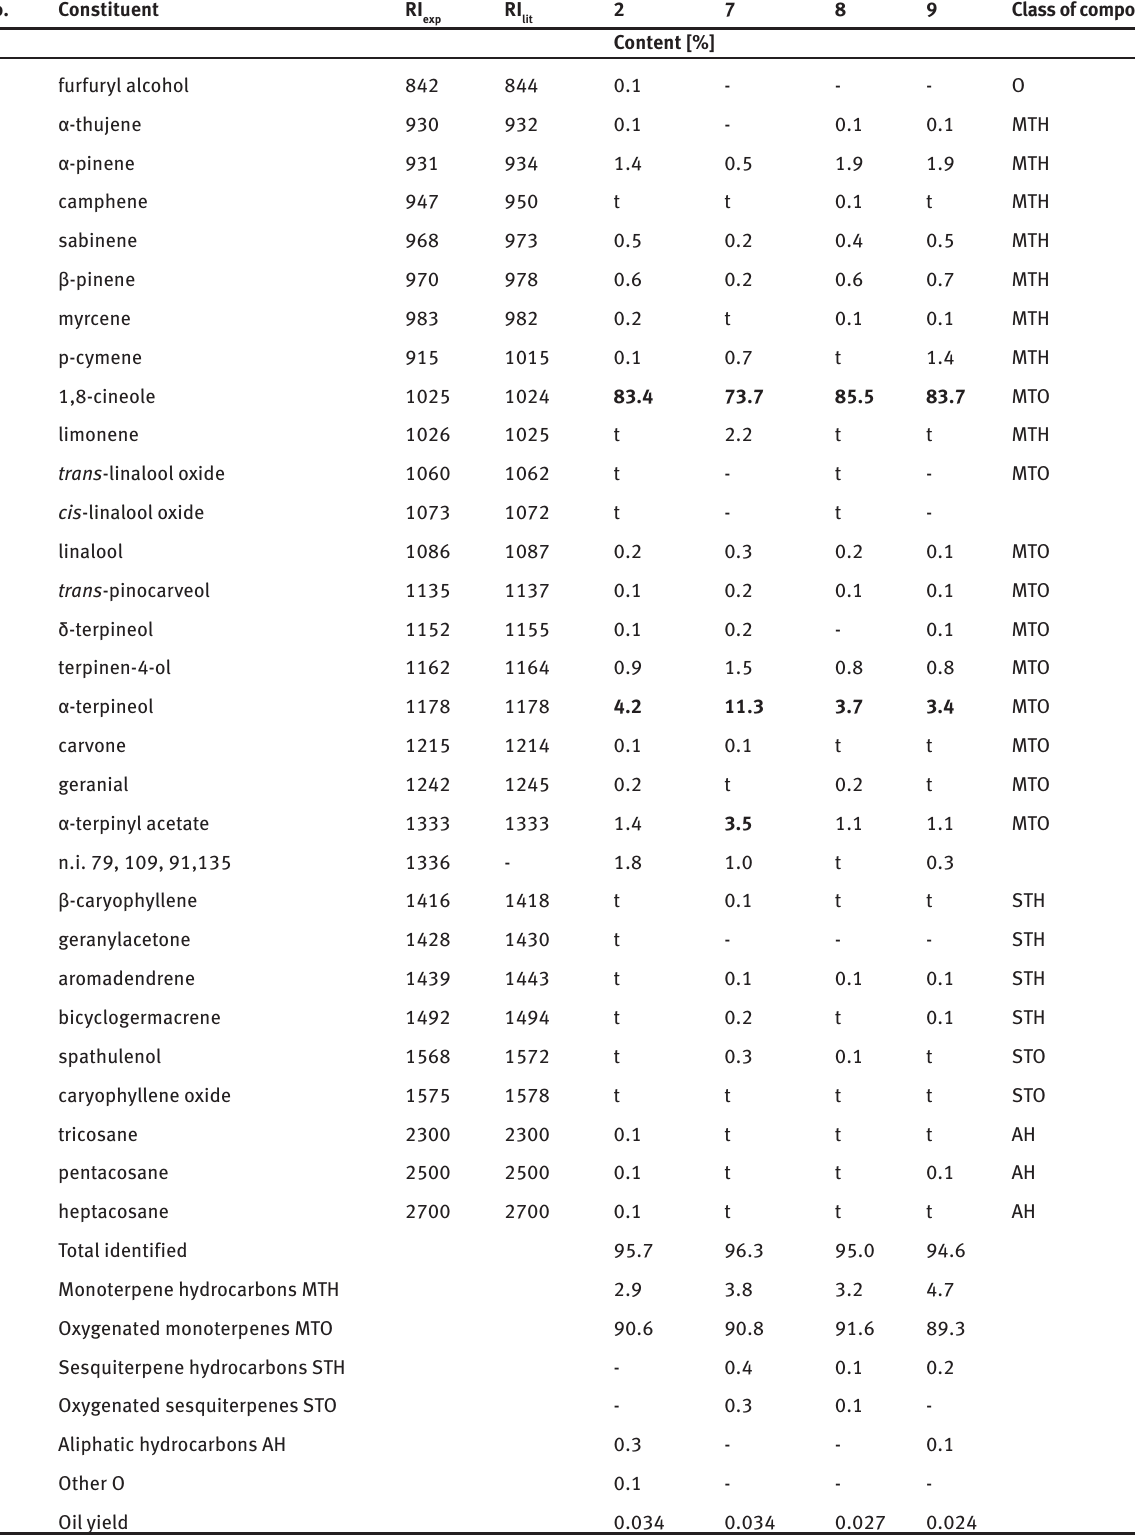
, literature retention index; t, trace – percentage value less than 0.05%; n.i., not lit